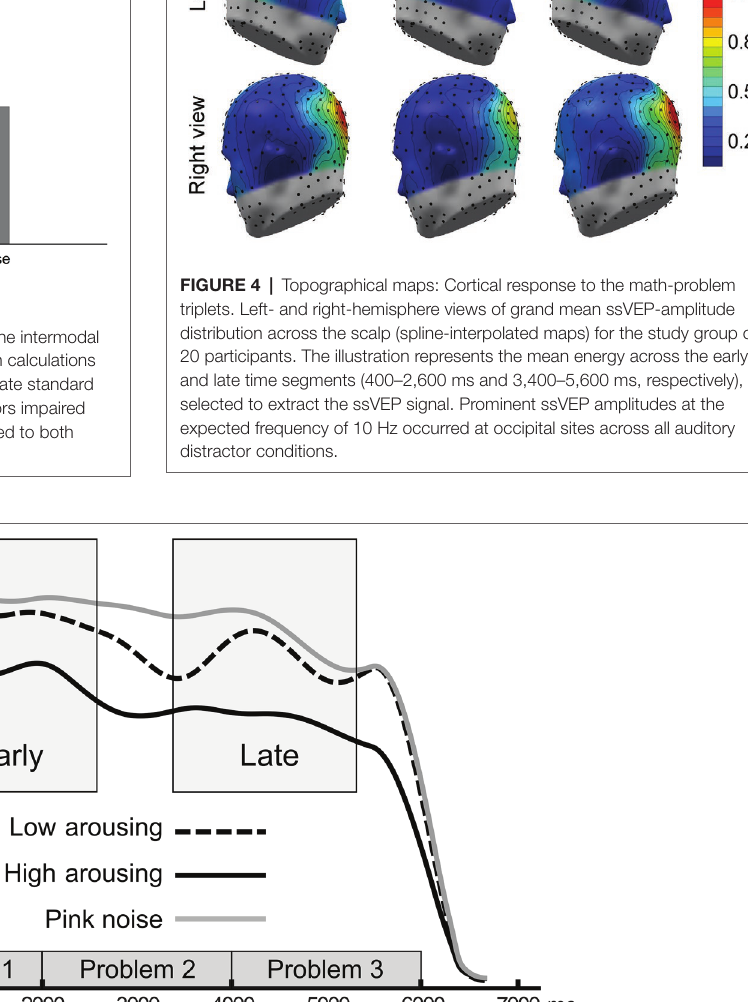
TABLE 1 | Cell descriptives of the steady-state response by time window and distractor type for the participant group ( n = 20).